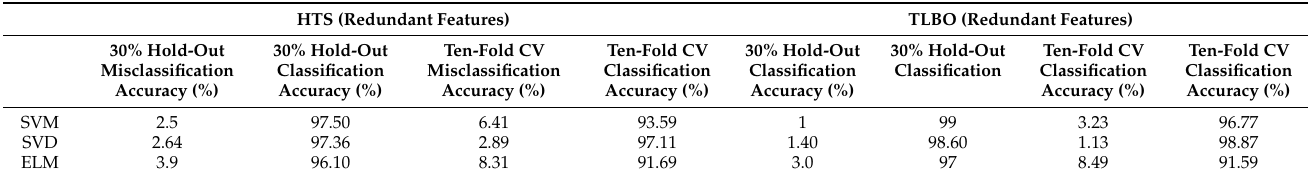
Table 6. Compound fault prediction accuracy with redundant features.